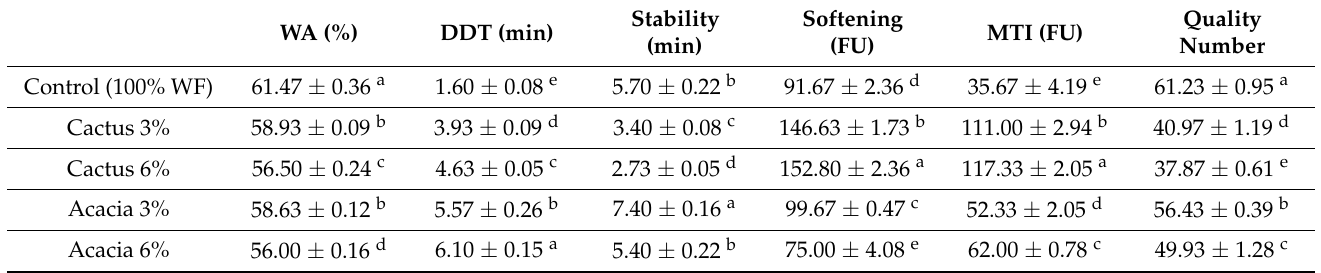
Table 2. Effect of acacia and cactus gums on the dough mixing